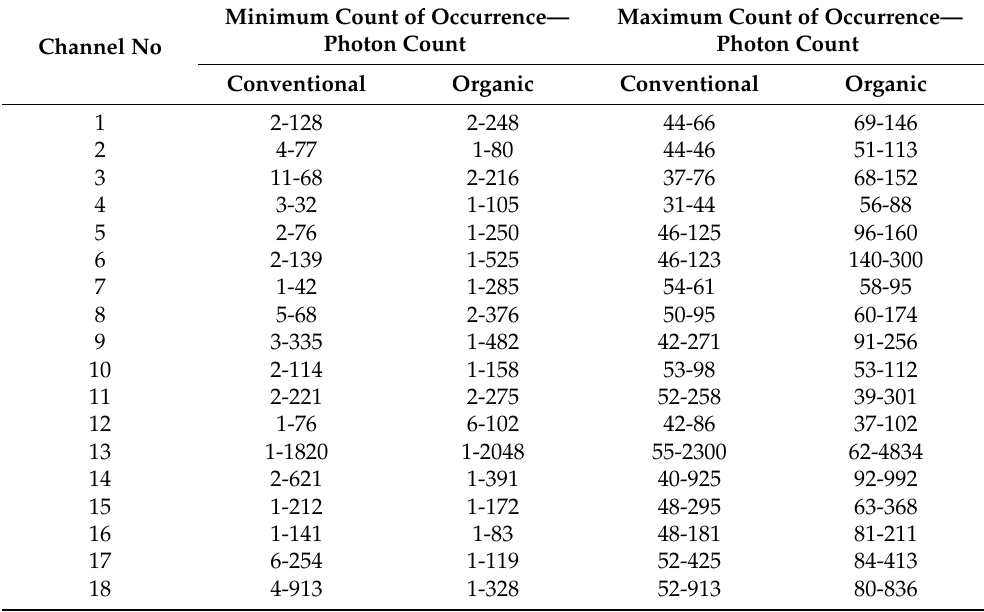
Table 4. Eighteen-channel photon count distribution and its number of occurrences for conventional and organic tomato. Minimum Count of Occurrence— Photon